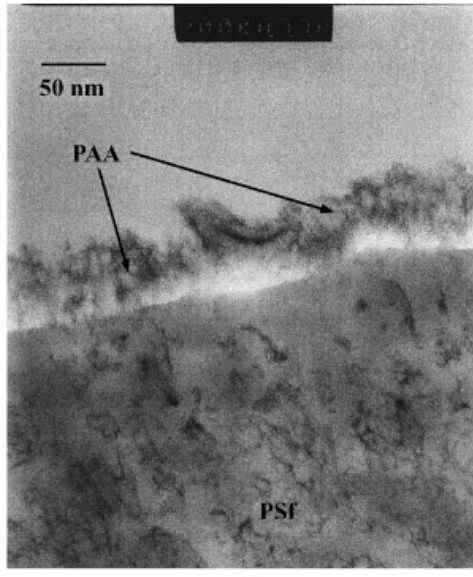
Figure 8. TEM image of a nano-film of grafted on polyacrylic acid (PAA) over polysulfone (PSf) [29]. Table 2. Different studies performed by TEM for membrane characterization.